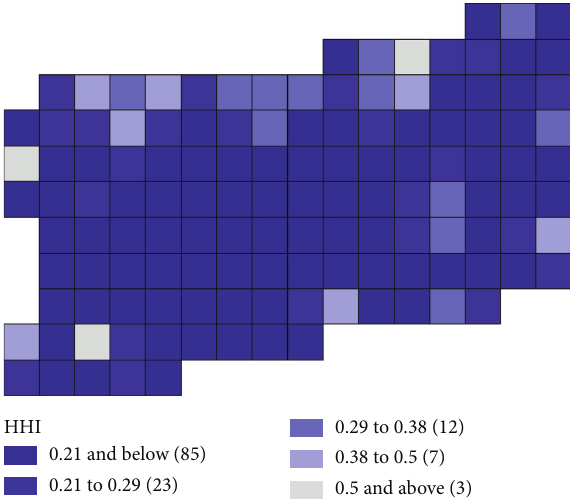
Figure 3: The degree of land mix (HHI).